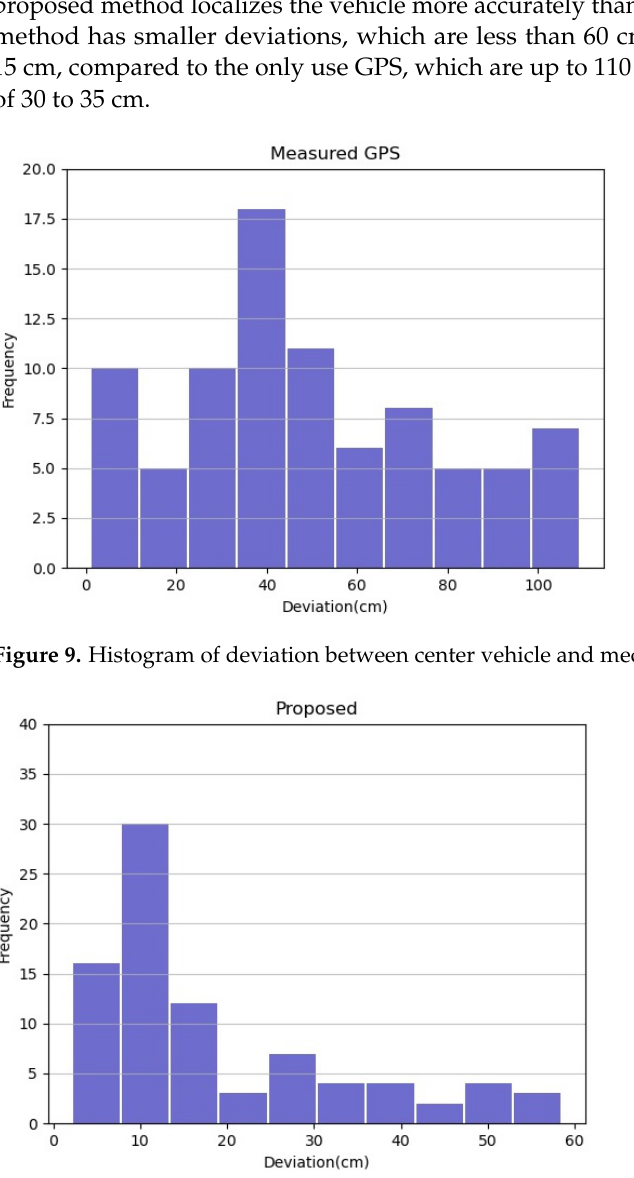
Figure 10. Histogram of deviation between center vehicle and median lane using the pro- posed